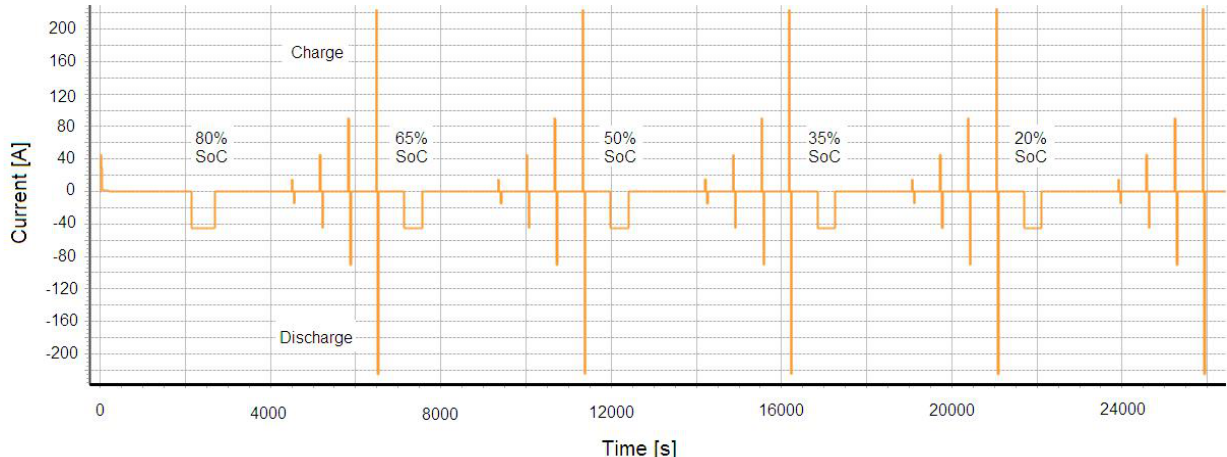
Figure 23. Extended HPPC pulse at different SoC level and state of